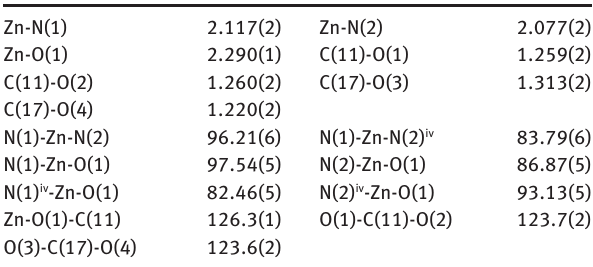
Figure 2 A packing diagram of [Zn(L)(Hcpdc) The hydrogen bonds are shown as dashed